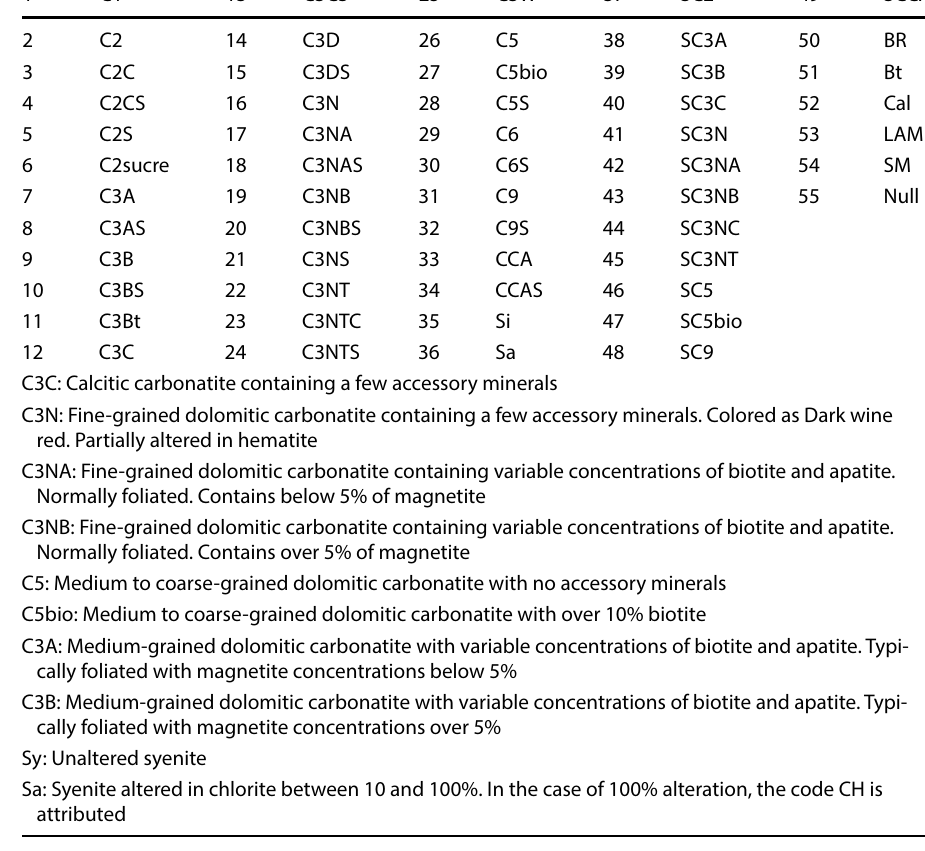
Table 1 The codified classification established and used by the Niobec Mine to describe the different lithological units. Adapted from Golder [34] and Lavoie [37]